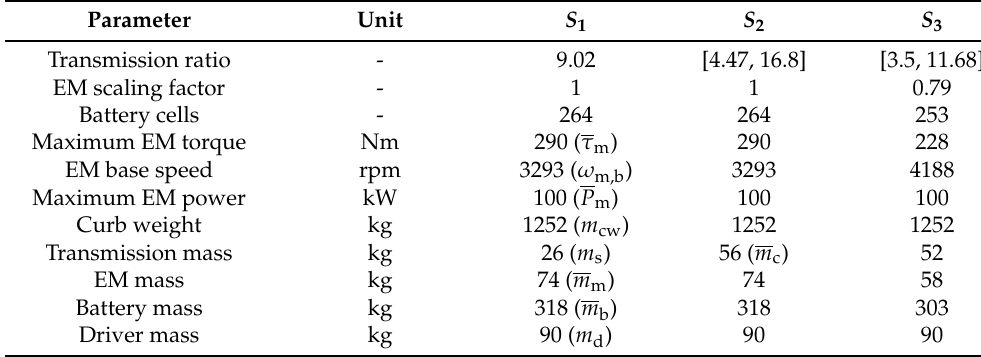
Table 1. Comparison of component parameters between S 1 , S 2 and S 3 .